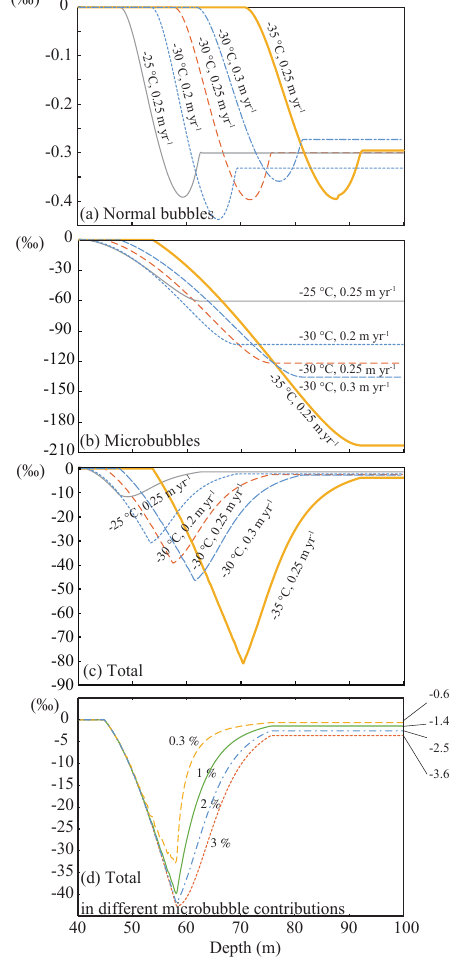
Figure 11. The simulated δ Ar / N 2 fractionation with depth in the firn for the normal bubbles and microbubbles with different tem- peratures and accumulation rates. Microbubble contribution was set to 2% except in (d) ; see also Table 3. (a) δ Ar / N 2 changes in the normal bubbles. (b) δ Ar / N 2 changes in the microbubbles. (c) To- tal δ Ar / N 2 changes (changes in the sum of the microbubbles and normal bubbles). (d) Total δ Ar / N 2 changes as in (c) but with dif- ferent microbubble contributions (0.3 to 3%) with a temperature of − 30 ◦ C and accumulation rate of 0.25miceyear − 1